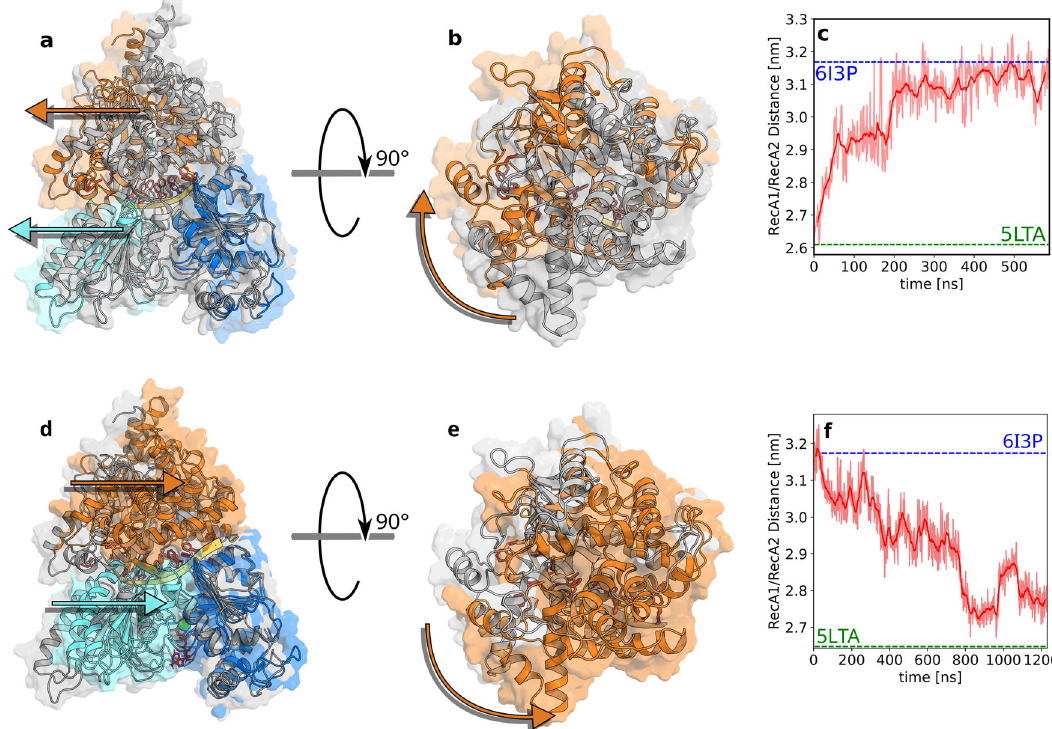
Fig. 2 Domain movements during the conformational cycle. a – c Opening transition and ( d – f ) closing transition of Prp43. a , d Front view and ( b , e ) top view at the beginning (gray) and end (multi-colored) of the respective process taken from the initial and fi nal frames of the opening or closing trajectory, respectively. Arrows highlight the motions of RecA2 domain (cyan) and CTD domain (orange) relative to RecA1 domain (blue). c Center-of-mass distance between RecA1 and RecA2 domains during opening and ( f ) during closing. Dashed lines indicate the RecA1 – RecA2 distances in the closed Prp43 structure (green, pdb code 5LTA) or in the open structure of the homologous Prp22 (blue, pdb code 6I3P). The time averages are drawn as dark red lines while the underlying data is drawn in pale